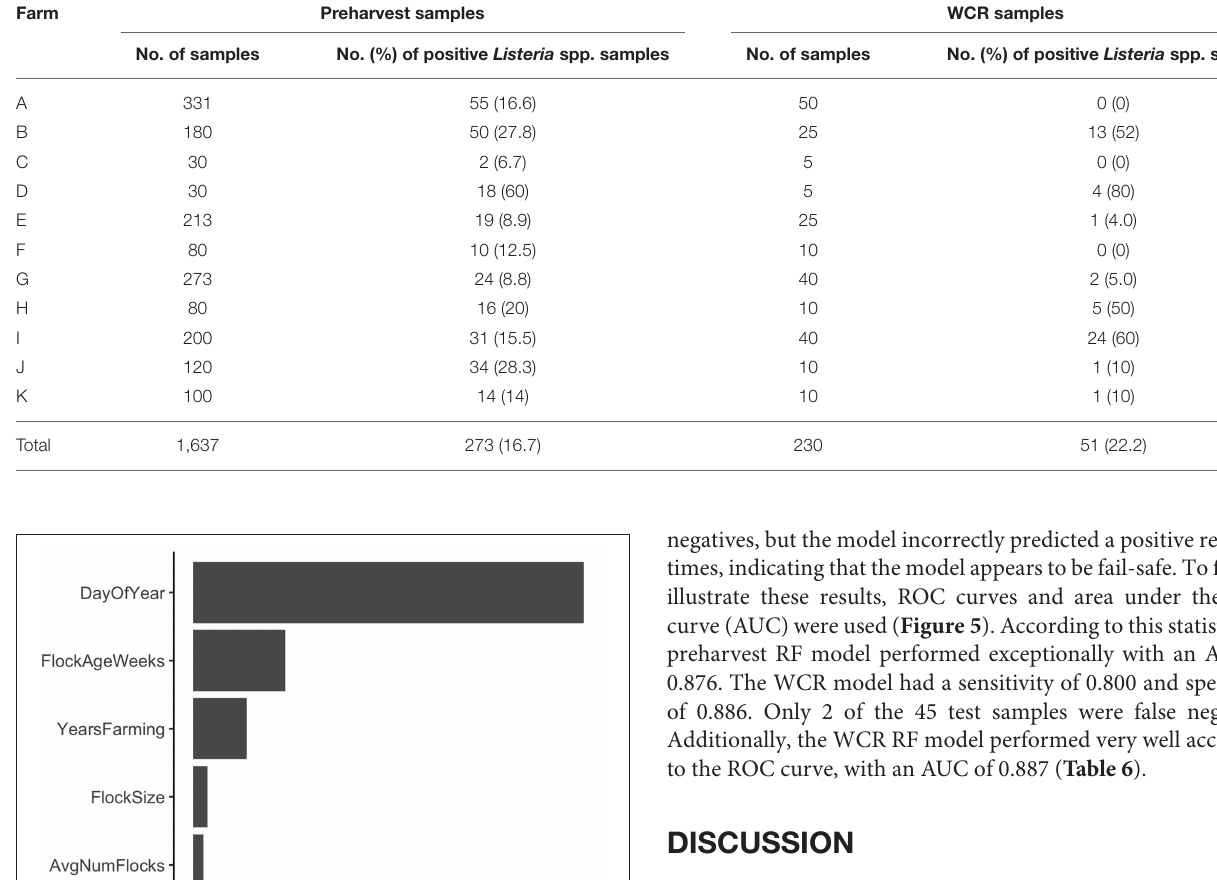
TABLE 5 | Prevalence of Listeria spp. by pastured poultry farm and sample type. Farm